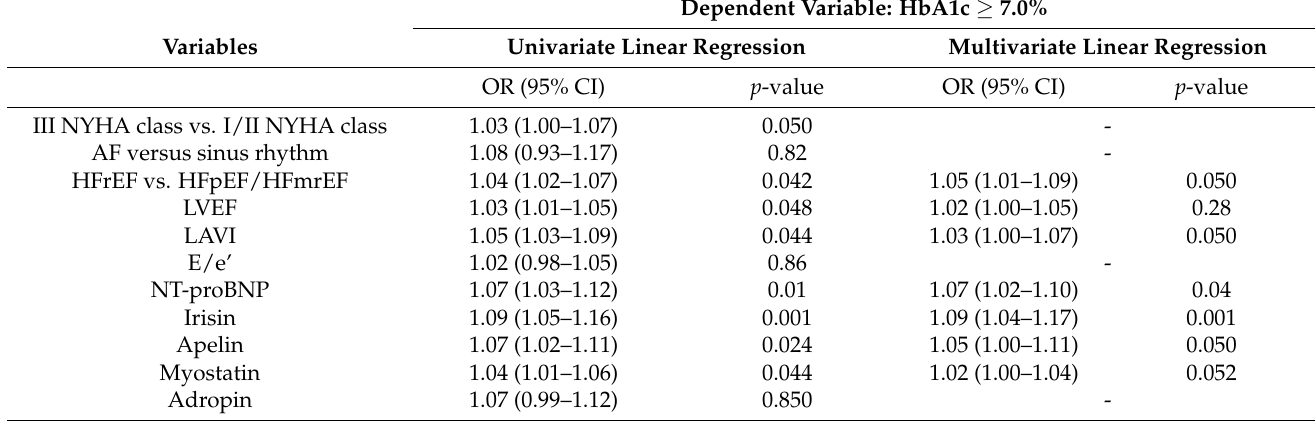
Table 2. Predictors of poor glycemic control in the study population. The results of the univariate and multivariate linear regression analyses adjusted to HOMA index and BMI.